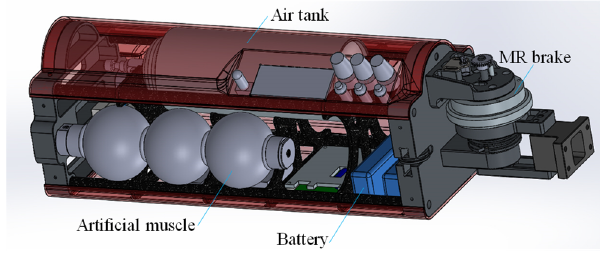
Figure 5. 3DCAD model of the developed Joint Module.